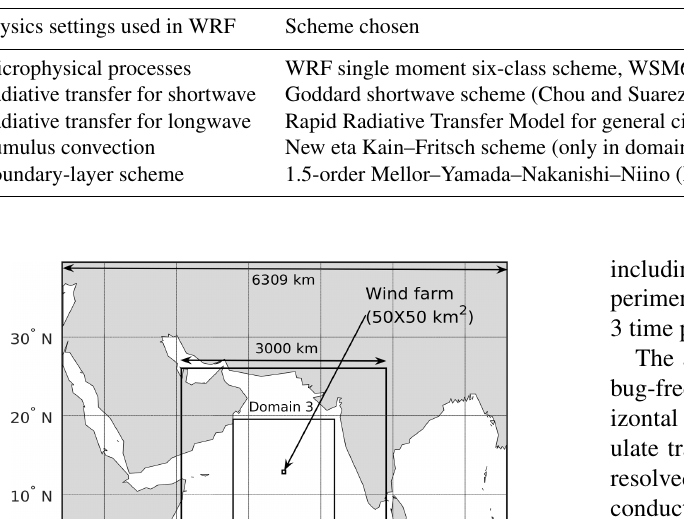
Table 1. Physics settings used in simulations.